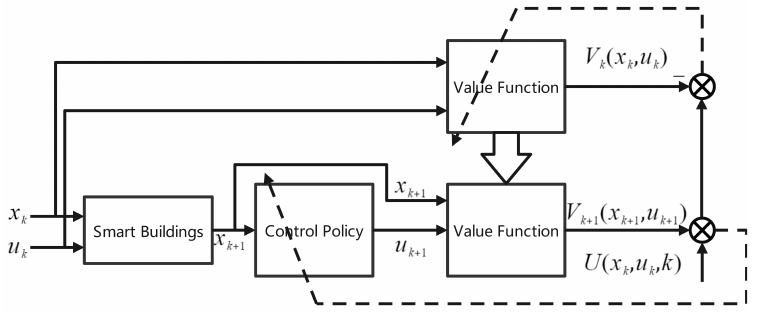
Figure 2. The structure diagram of online value